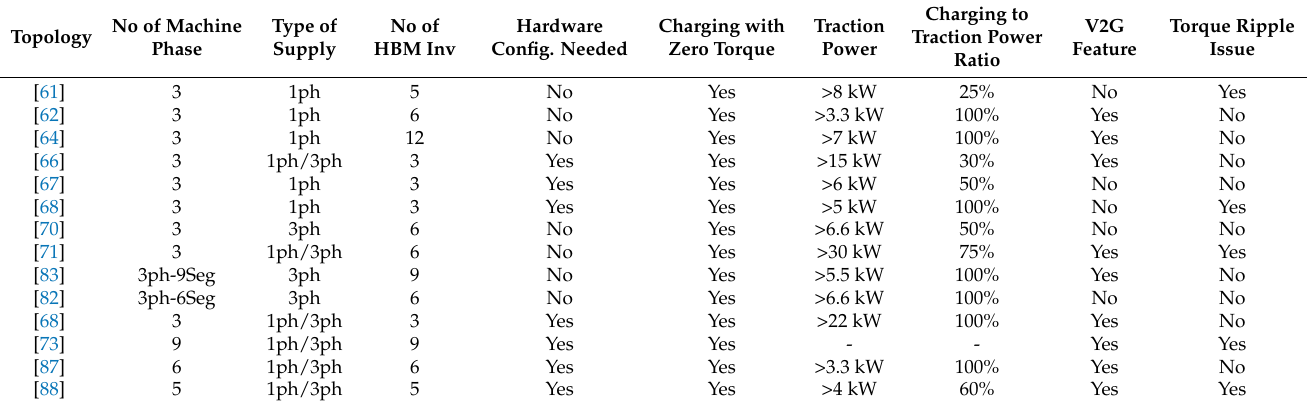
Table 7. Feature comparison of integrated on-board charger topologies.